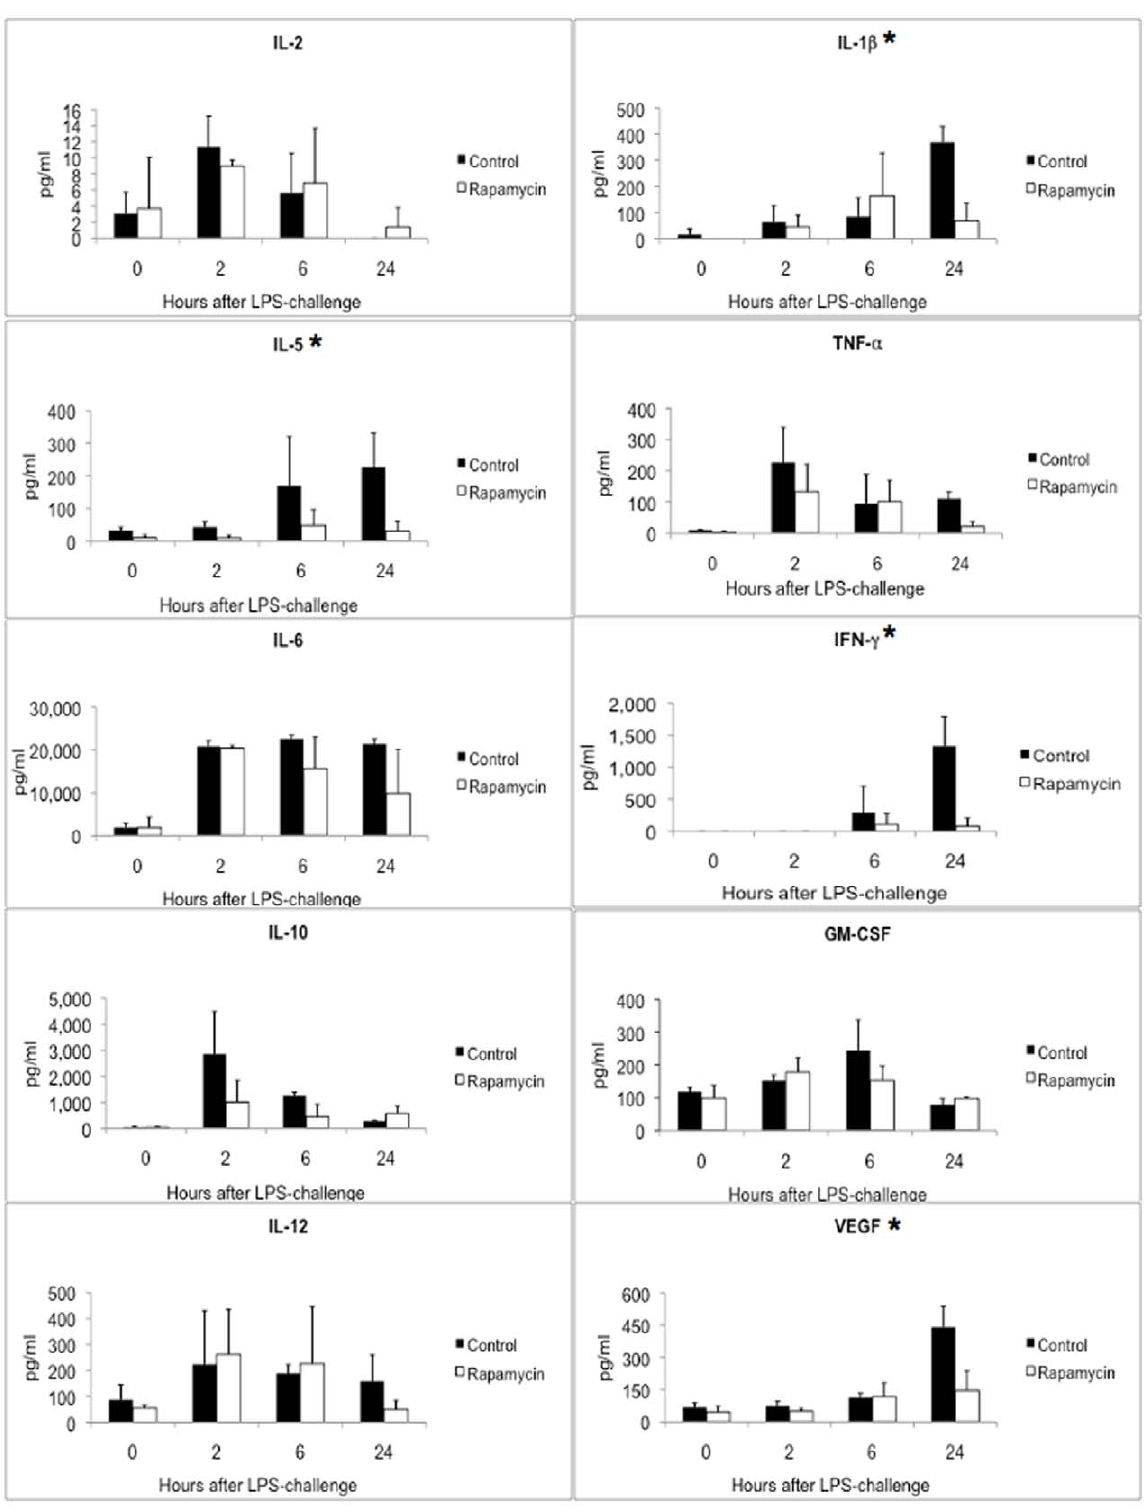
Figure 3. Rapamycin suppression of mTORC1-S6K was associated with lower cytokine levels. Following LPS treatment in vivo, circulating cytokine levels of LPS-challenged mice pre-treated with vehicle (solid bar) or rapamycin (open bar) at 0 (no LPS), 2, 6, and 24 hr post LPS are shown here. Data are expressed as mean of three mice in each group at each time point, with error bars representing standard deviations. Statistical analysis was performed using Repeated Measures ANOVA, and p values , 0.05 are considered as significant (*). mTORC1-S6K suppression by rapamycin led to decreased circulation levels of IL1- b , VEGF, IFN- c and IL-5. There was a trend toward lower TNF- a levels with a p value of 0.058.